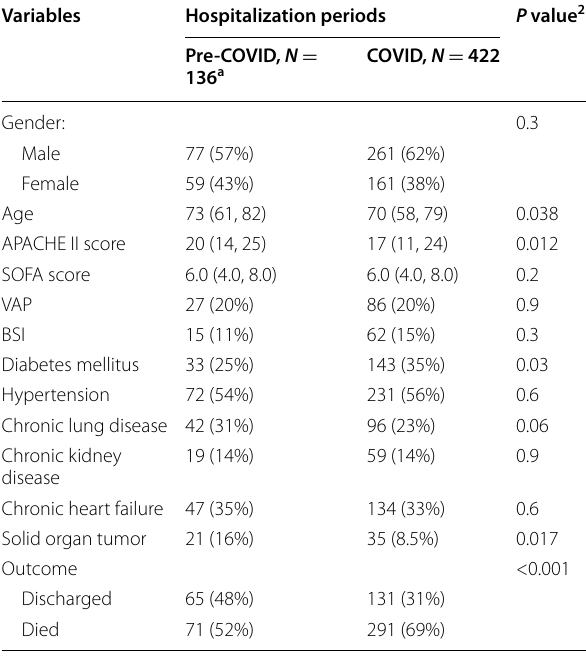
Table 1 Demographic, baseline, and outcome characteristics of the study population